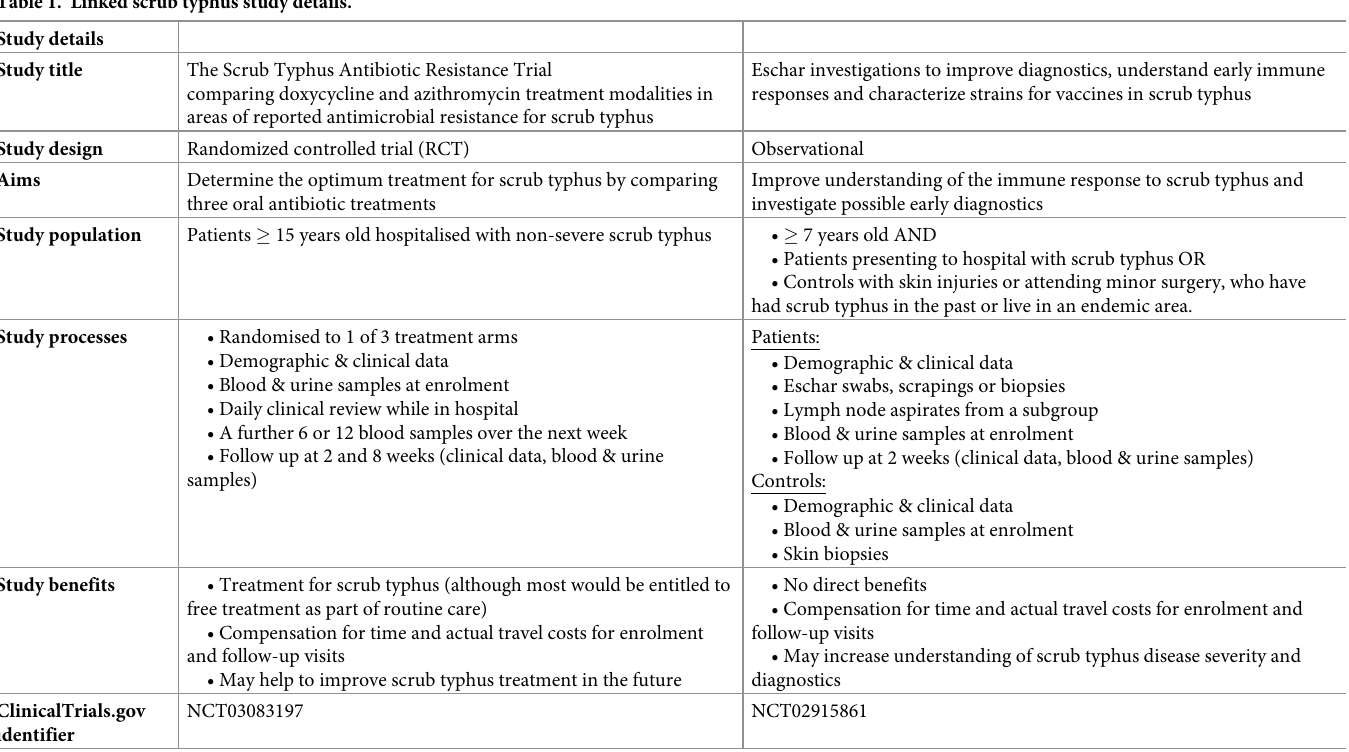
Table 1. Linked scrub typhus study